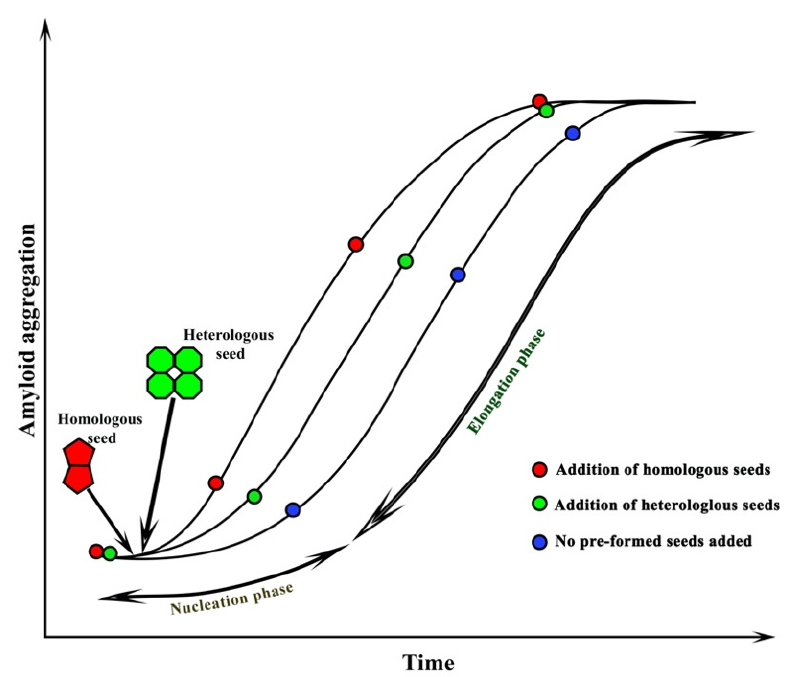
Figure 1. Amyloid seeding and aggregation . The addition of preformed seeds reduces the lag phase leading to faster aggregation. The seeds can be homologous or heterologous. Homologous seeds, which have the same nature as the existing nuclei, lead to homologous seeding, whereas the heterologous seeds differ from the initial nuclei and lead to heterologous or cross-seeding. Many proteins enter the amyloid formation stages and end up forming elongated fibers with the backbone spine composed of β -sheets. As of today, there are over 25 amyloid proteins that have been identified to form amyloid and are associated with diseases. The most common amyloid proteins are A β , tau, α -syn, hIAPP, and PrP, which can also cross- seed among